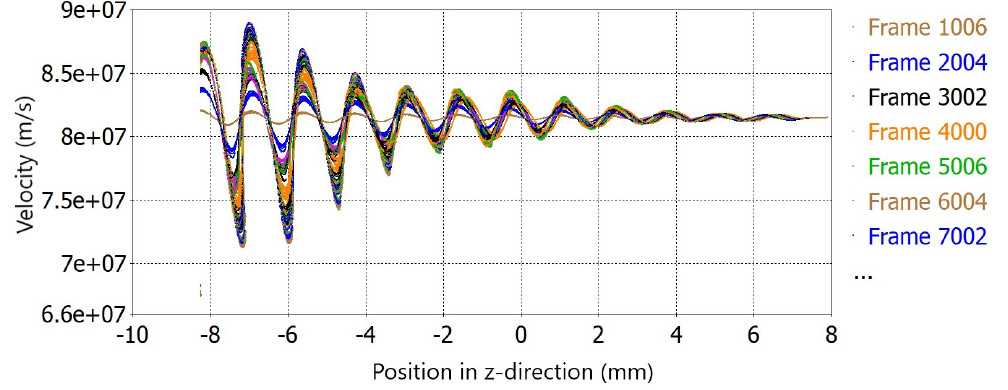
Figure 4. Particle velocity in